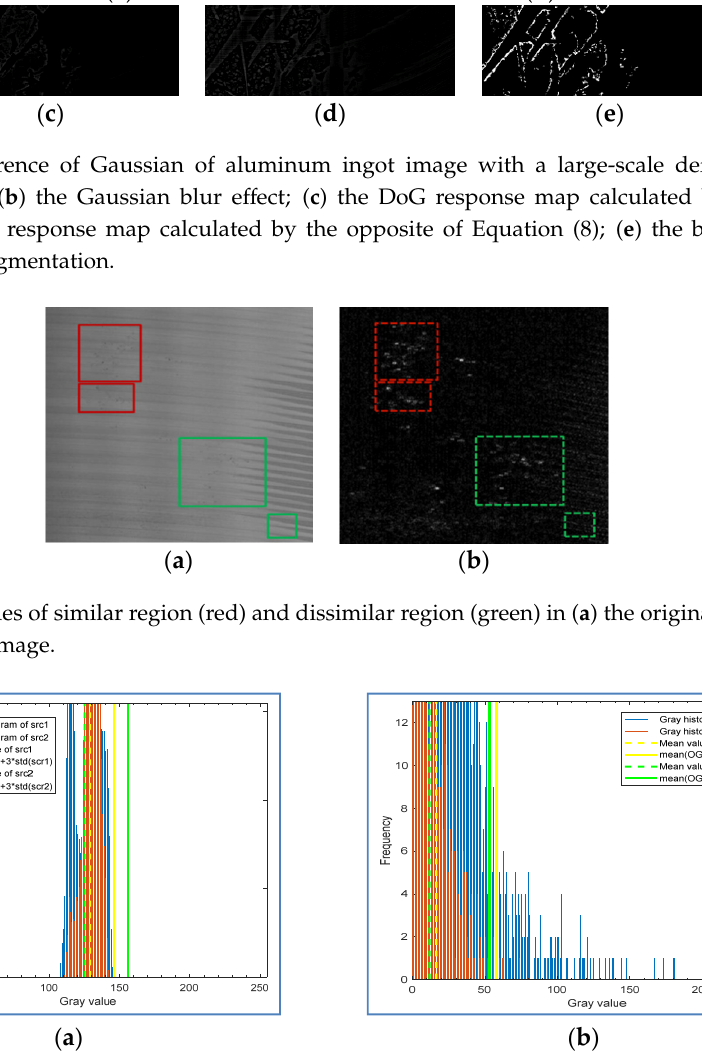
Figure 9. Gray histogram and statistical information of two dissimilar regions: ( a ) original images; ( b ) gradient images.